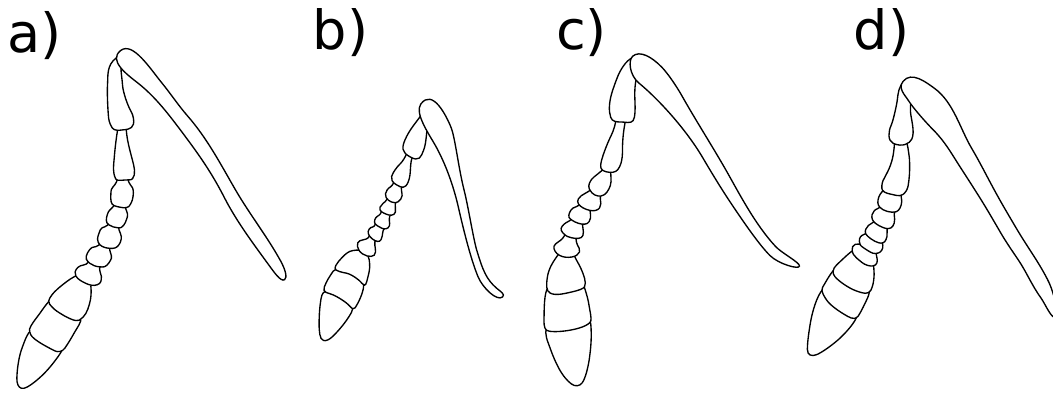
Figure 4. Right antennae, anterior view, of Kuschelysius species. ( a ) K. hollowayae ; ( b ) K. durus ; ( c ) K. verbalis ; ( d ) K. nitens ; scale bar = 1